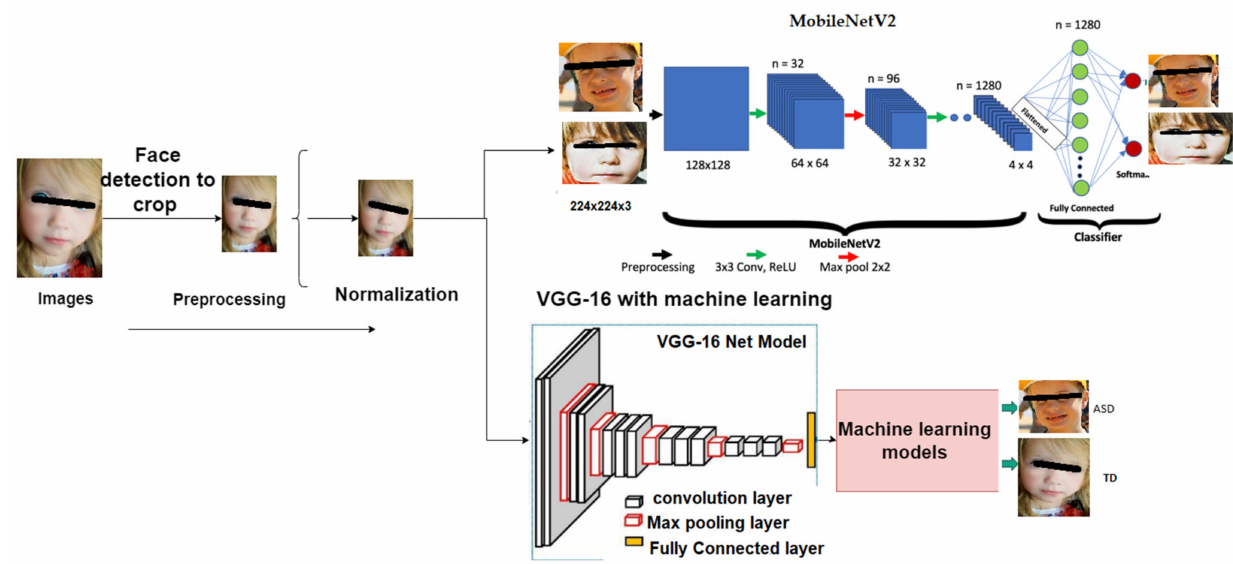
Figure 3. Framework of the proposed recognition system.